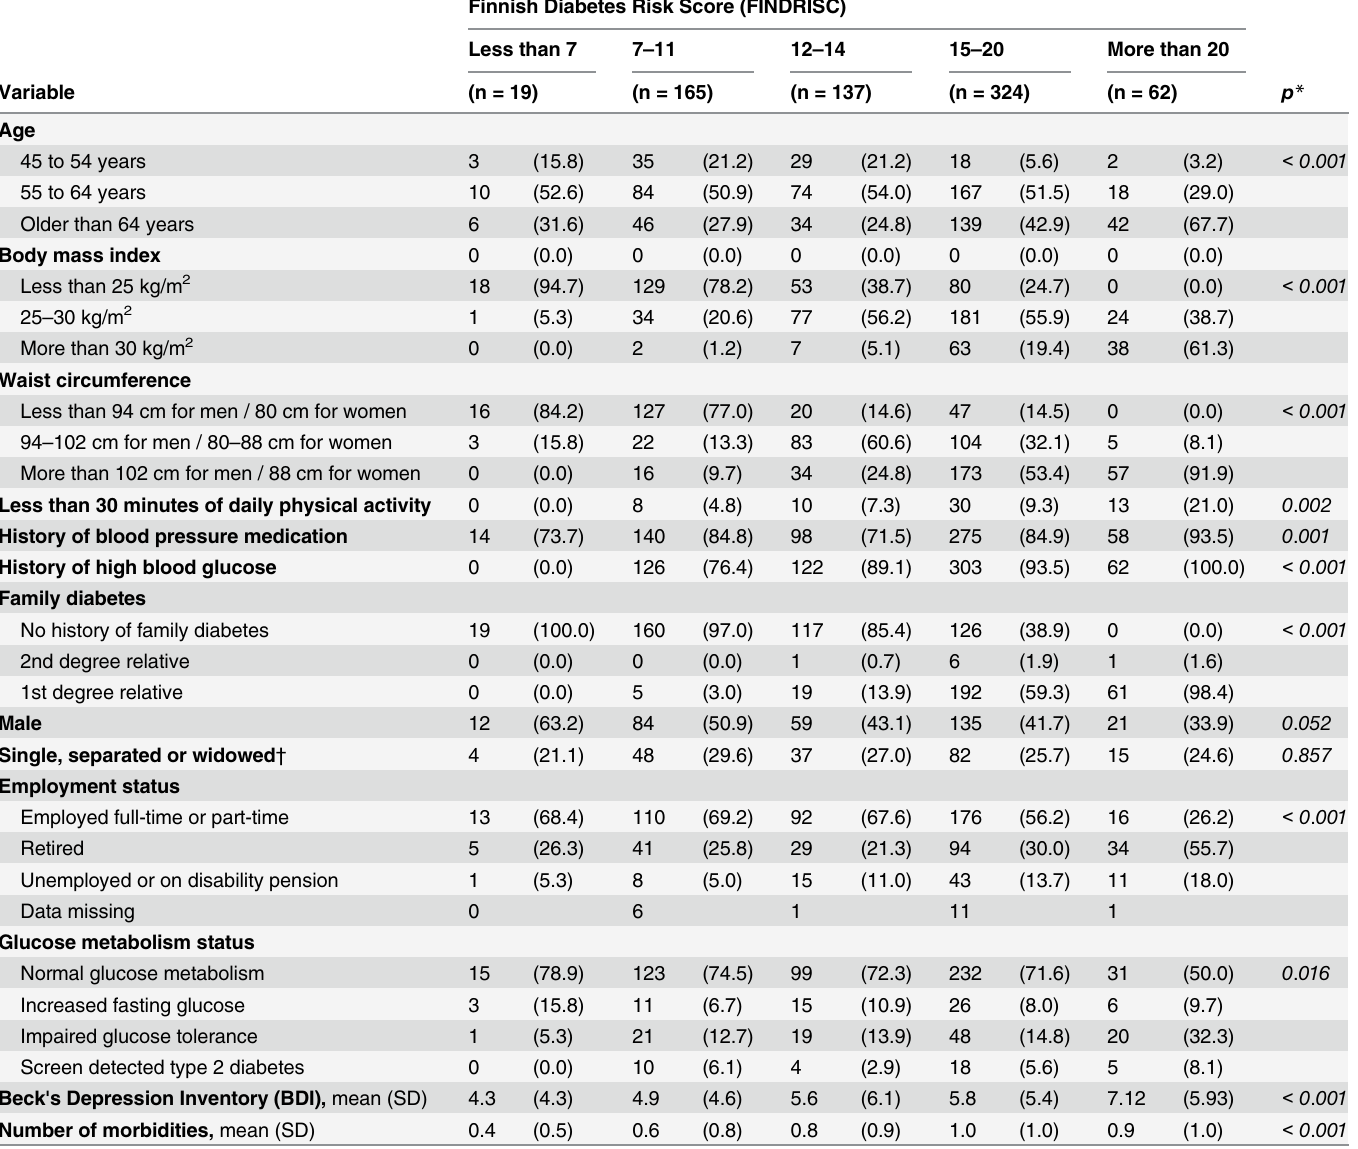
Table 1. The mean (SD) and median (range) FINDRISC scores were 14.8 (4.23) and 15 (2 to 25), respectively. Overall, 95% (n = 672/707) of the observed FINDRISC scores were between 6 and 22. The mean (SD) and median (range) 15D index values were 0.910 (0.077) and 0.926 (0.564 to 1), respectively. The mean and median SF-6D values were 0.770 (0.115) and 0.780 (0.487 to 1), respectively. The observed ceiling effect was modest in both HRQoL index Table 1. The characteristics of the participants across the diabetes risk (FINDRISC) categories. Finnish Diabetes Risk Score